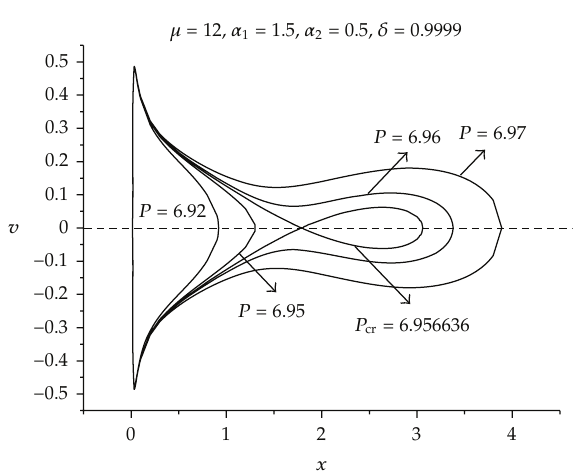
Figure 5: Phase diagrams for di ff erent values of P and for μ (cid:8) 12, α 1 (cid:8) 1 . 5, α 2 (cid:8) 0 . 5, and δ (cid:8) 0 .